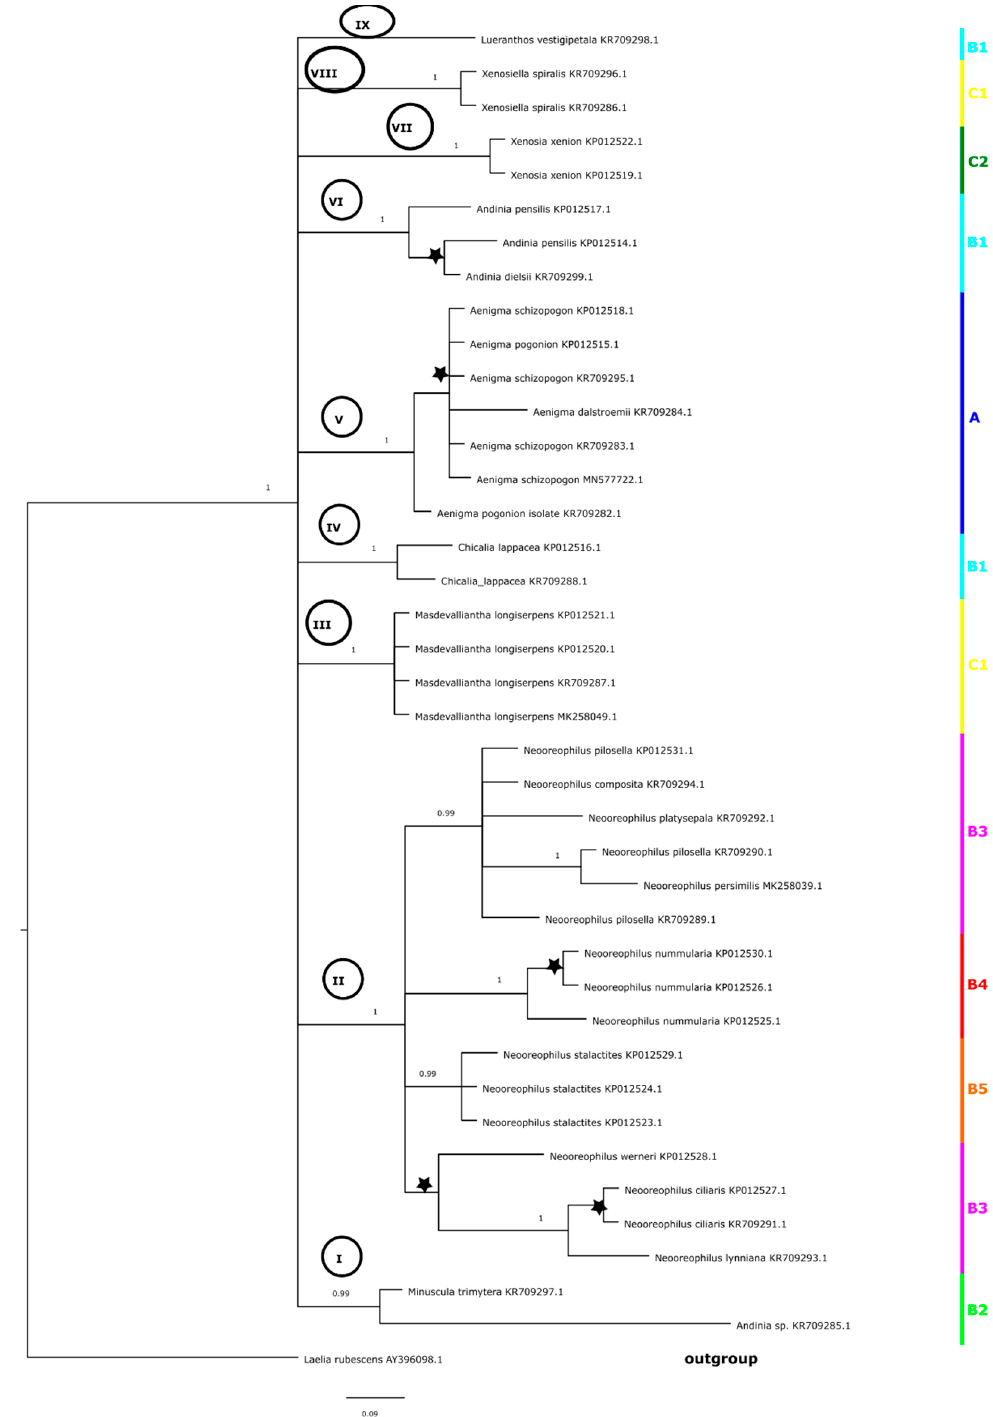
Figure 4. Majority-rule consensus tree obtained in Bayesian analysis of part of mat K gene for Andinia s.l. Values above branches represent posteriori probabilities; values with pp < 0.9 are indicated with an asterisk. The main and strong supported clades on the tree are marked with the numbers I–IX. Discussed groups of species are marked as A–C2.